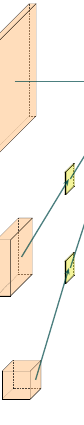
Figure 2. Illusion of the module of